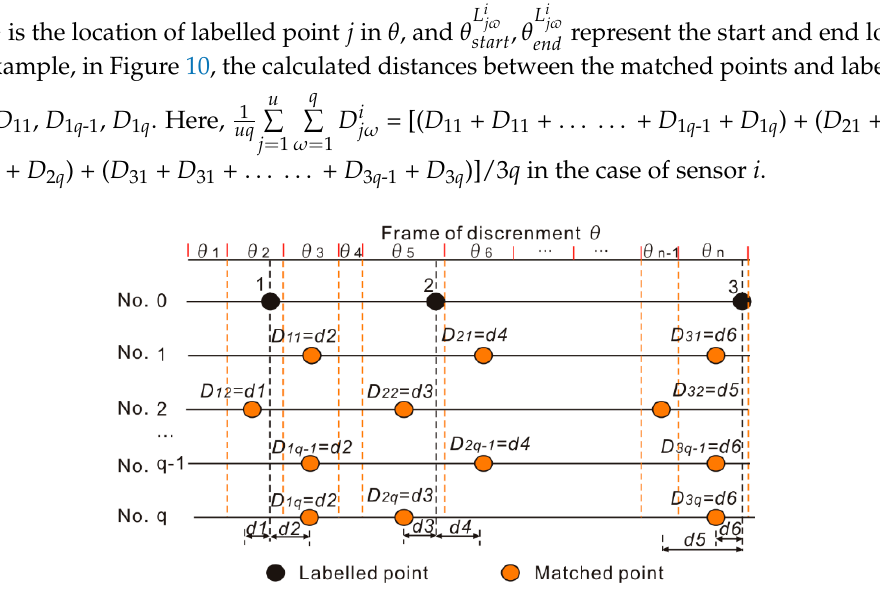
Figure 10. Calculating the matching errors for assigning the weight of sensor i.